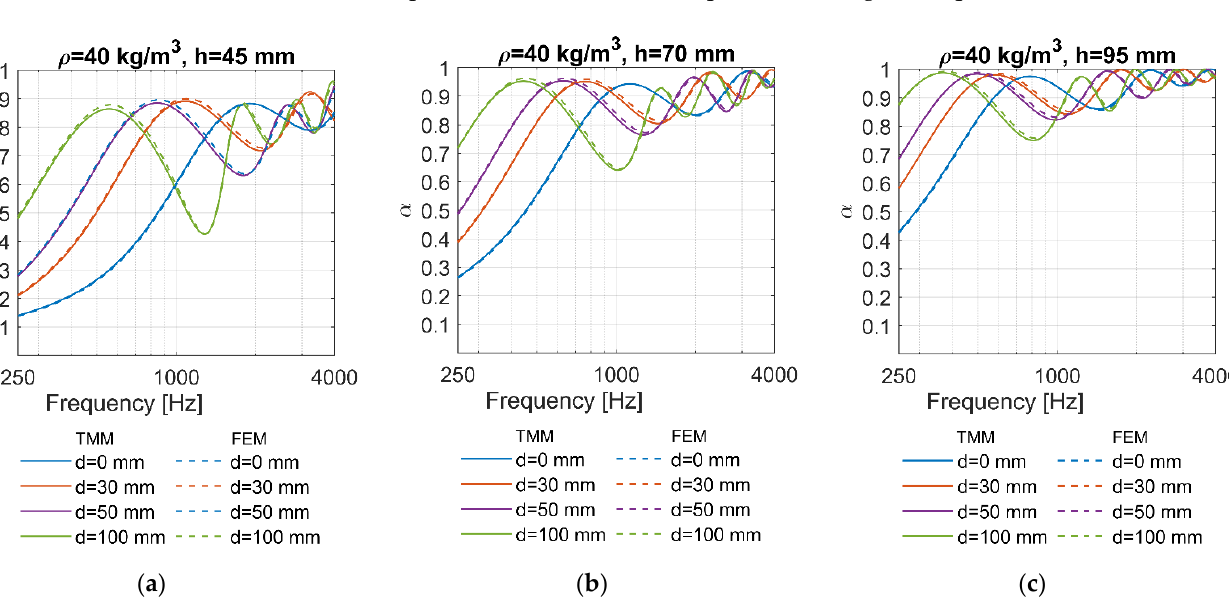
Figure 11. Predicted relationship between thickness, h , density, ρ , and frequency after which the sound absorption coefficient begins to become larger than 0.8, f 0.8 , for the considered RPU foams.